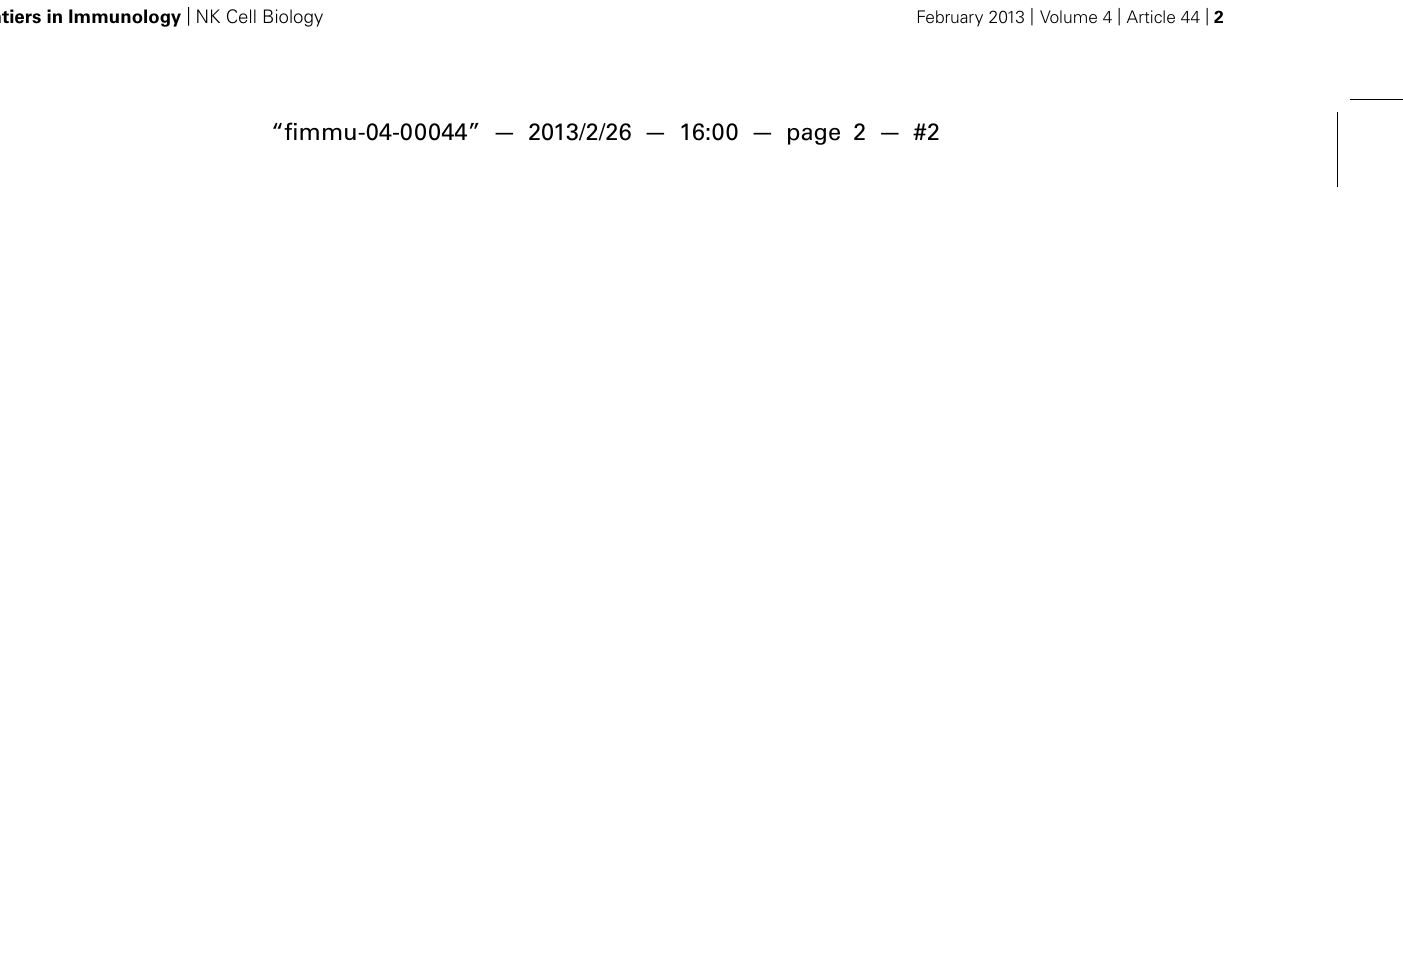
FIGURE 1 | Summary of canonical miRNA biogenesis and function. DNA (1) is transcribed by PolII into the pri-miRNA (2), which is then further processed by Drosha/DGCR8 into the pre-miRNA (3).This pre-miRNA is exported from the nucleus through exportin 5, then processed by Dicer to the